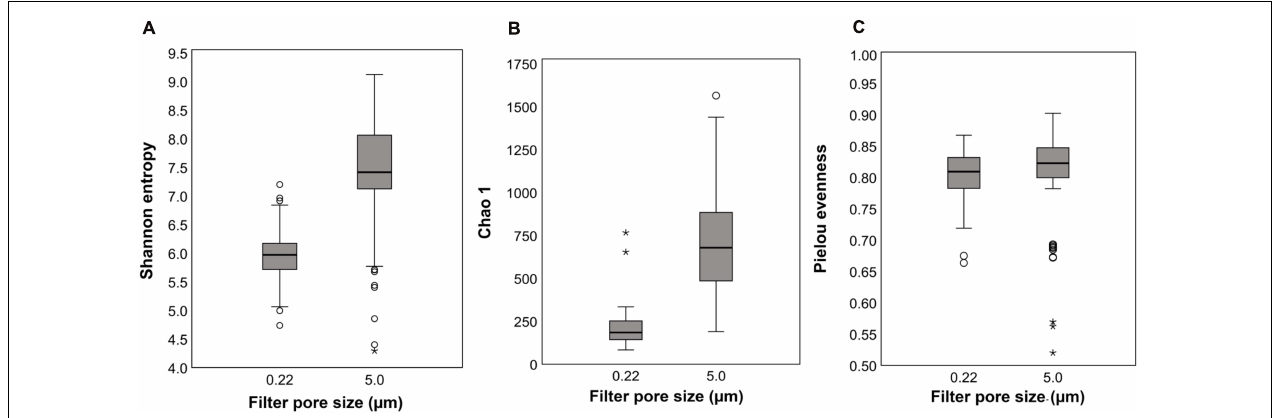
FIGURE 2 | Alpha diversity indices: Boxplots of means and standard deviations (SD) of within-sample diversity from all sampling locations for 0.22- and 5.0- µ m pore size filters; (A) Shannon (richness and evenness), (B) Chao1 richness estimate, and (C) Pielou’s community evenness.